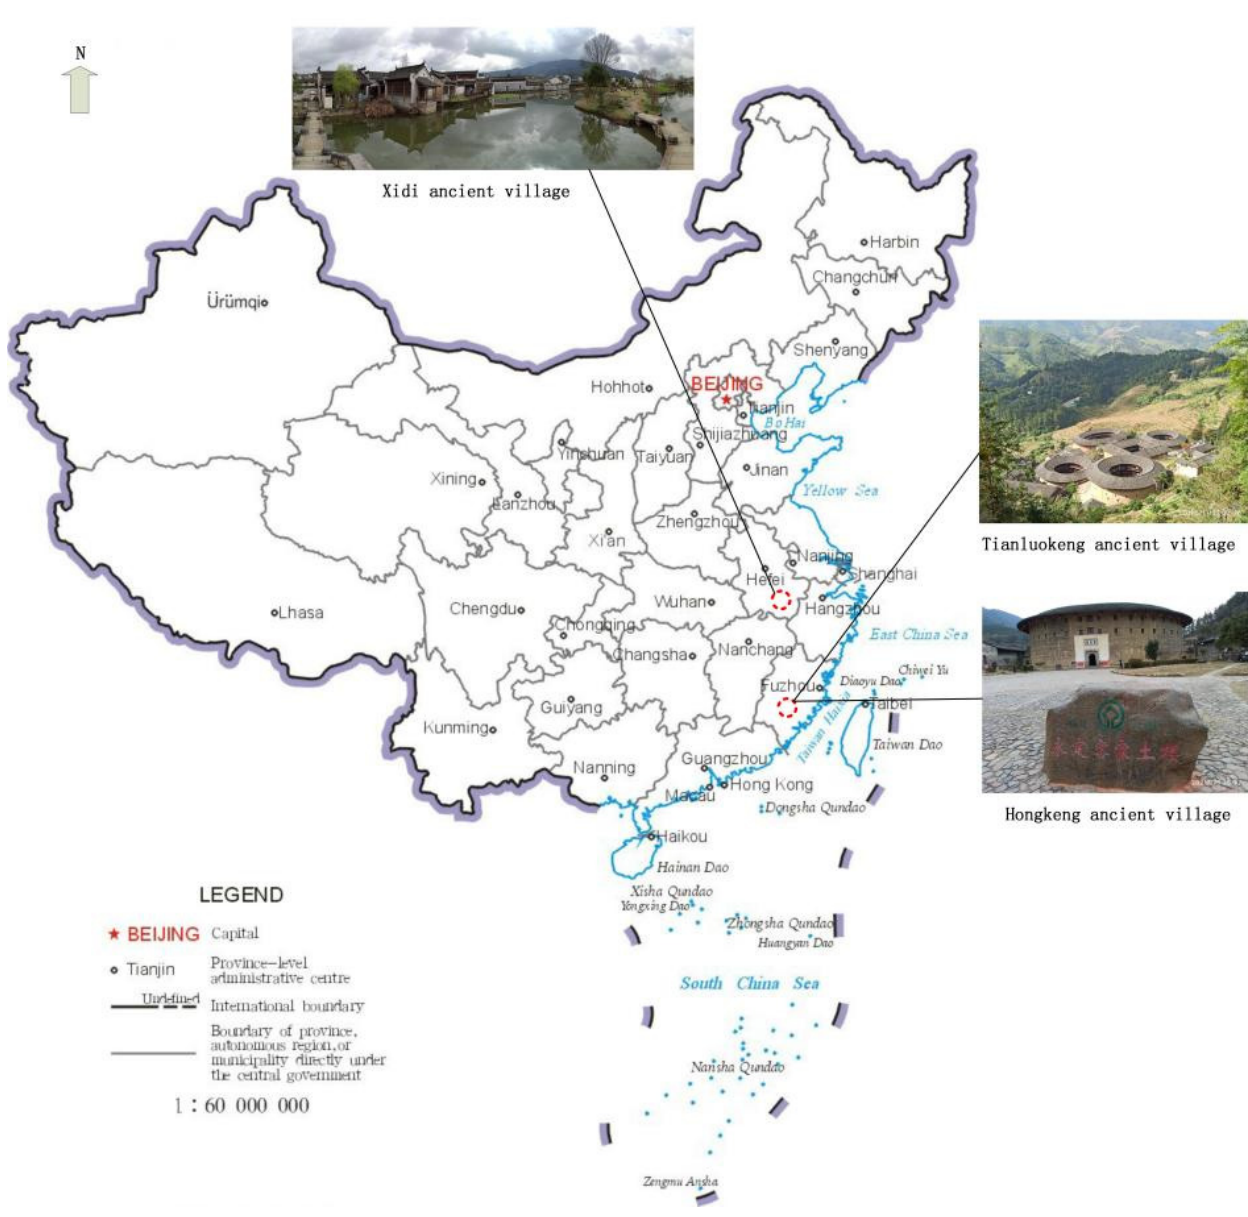
Figure 1. The ancient villages in Southern Anhui and Fujian Tulou.